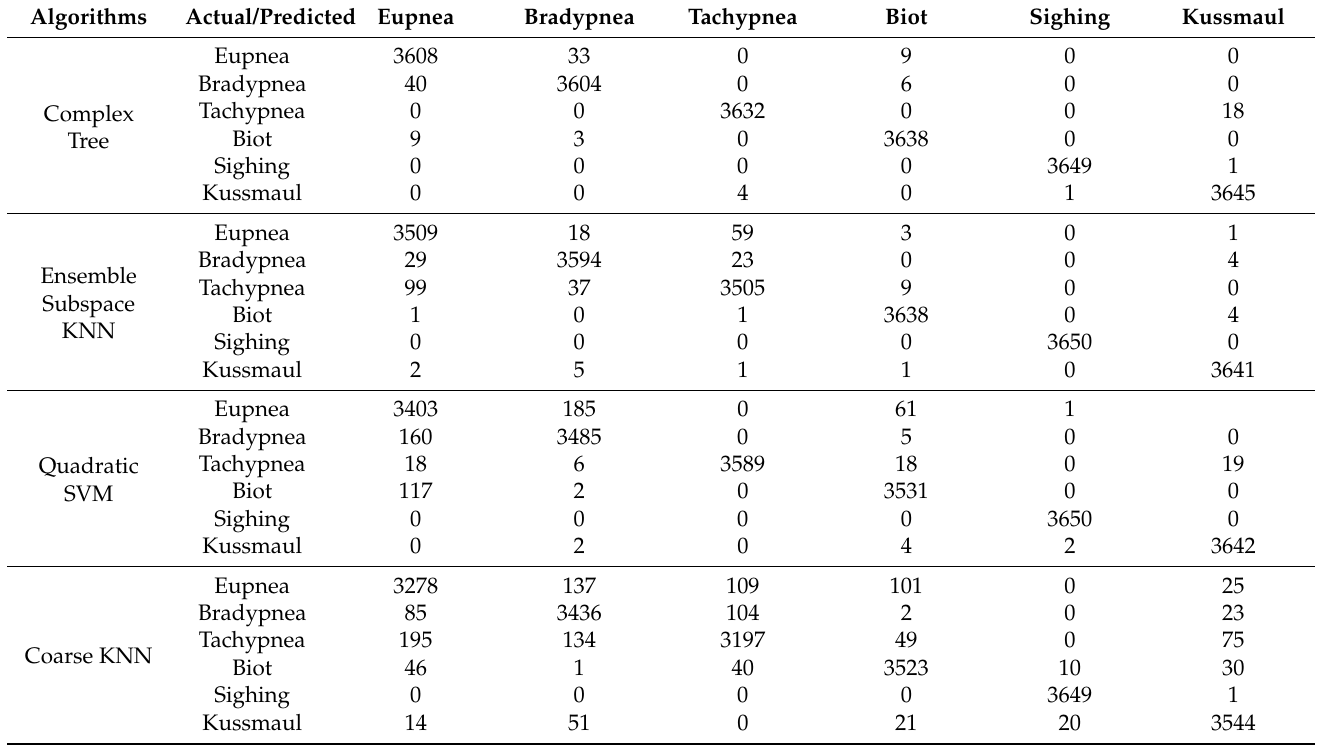
Table 4. Confusion matrix of ML algorithms.